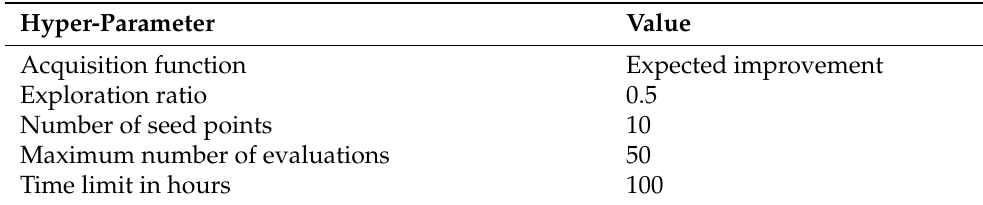
Table 4. Bayesian optimization hyper-parameters.